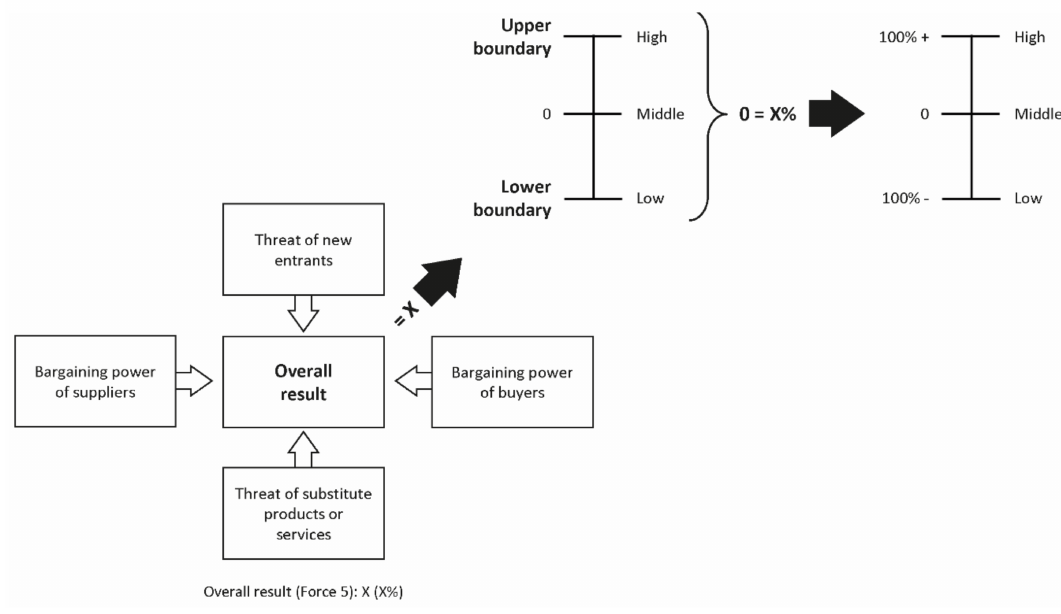
Figure 1. Porter’s five forces analysis diagram